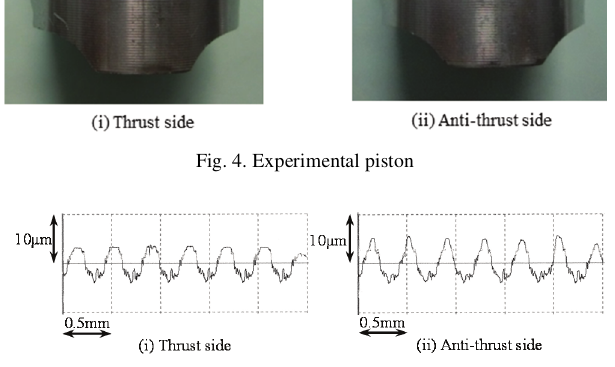
Fig. 5. Roughness of piston skirt sliding surface other than grooves (after